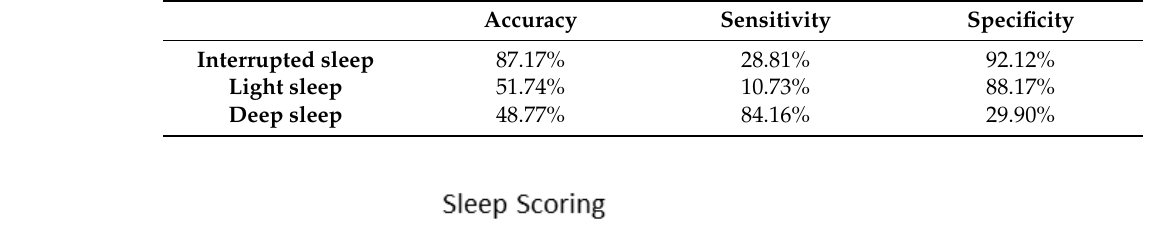
Table 1. Accuracy, sensitivity, and specificity for sleep–wake determination.